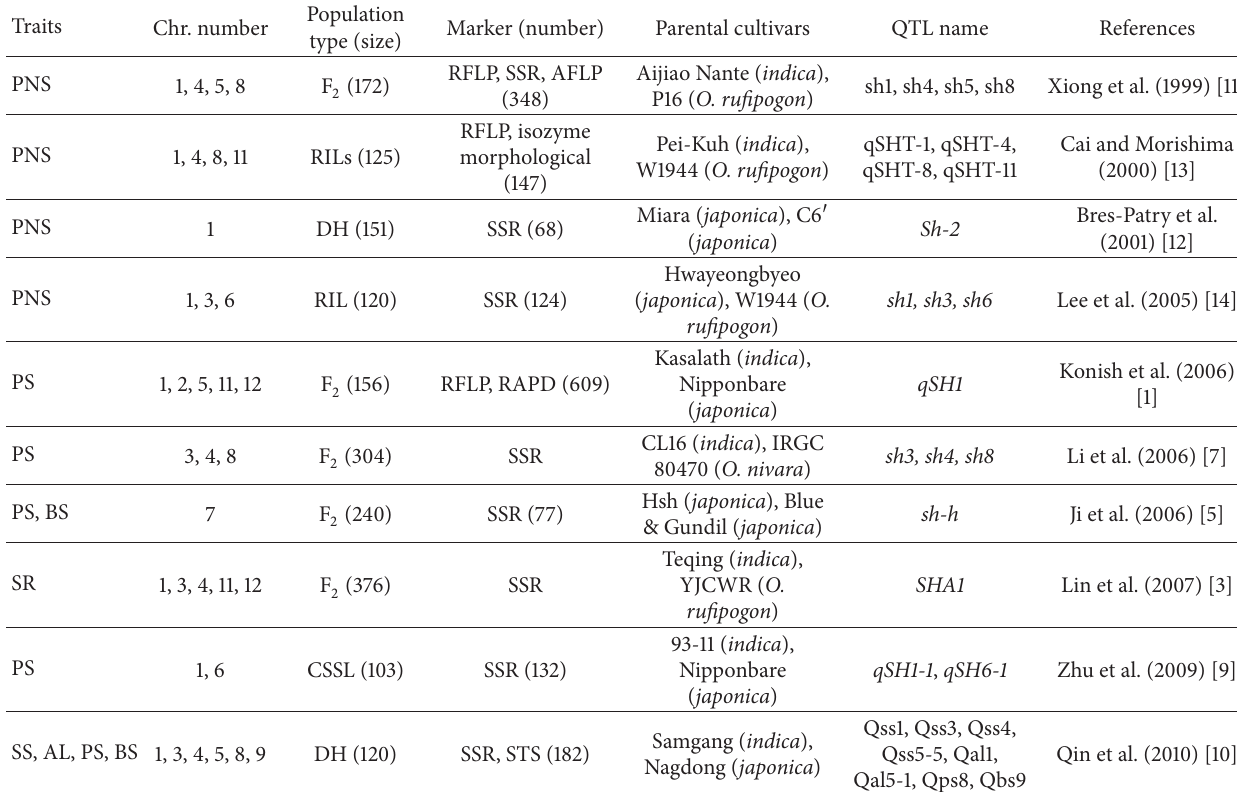
Table 4: Comparison of QTL identified from previous